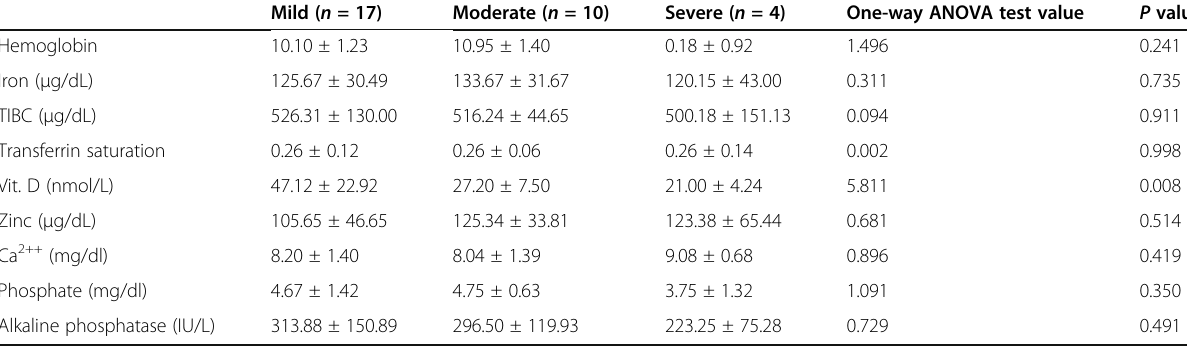
Table 6 Laboratory values among the patient group are classified according to pneumonia